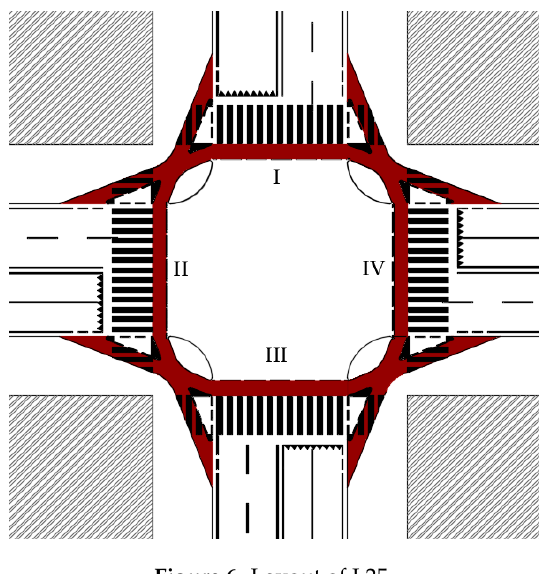
Figure 6. Layout of L25.